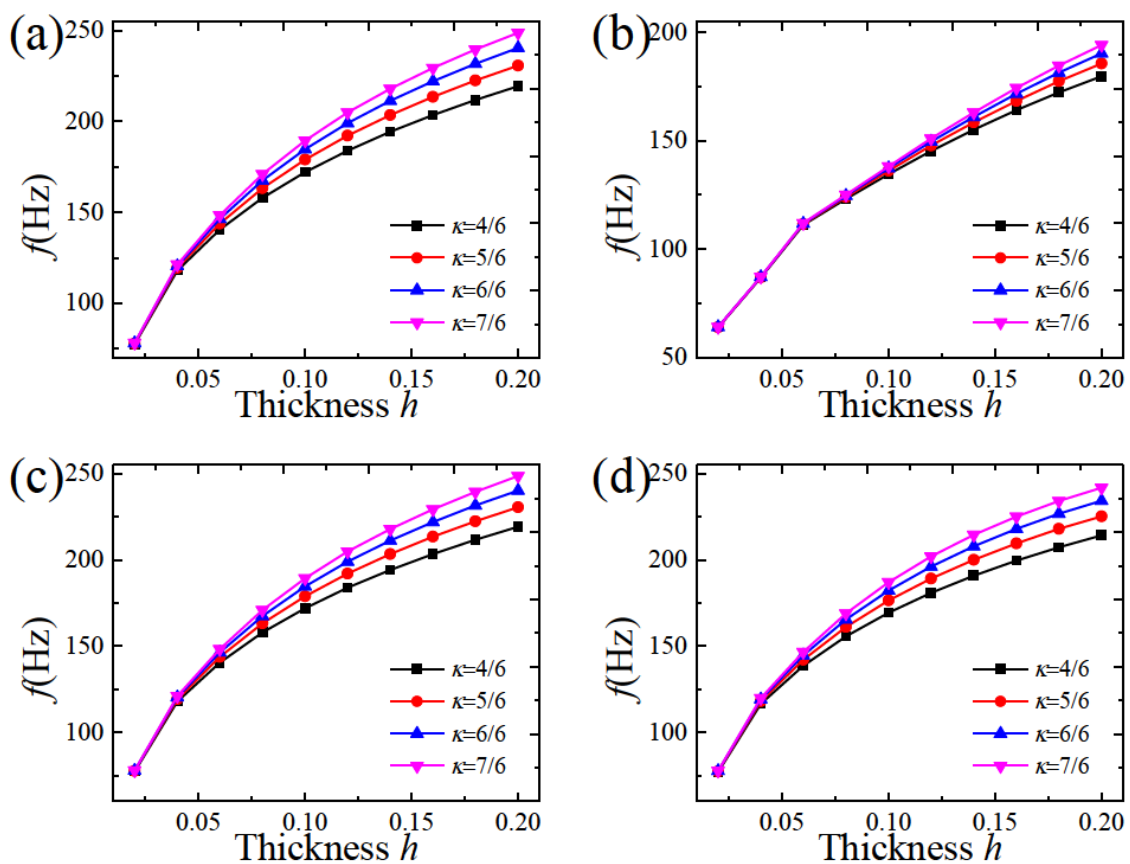
Figure 9: Fundamental frequency parameters versus thickness h for the UD-CNT panel with different shear correction factors and boundary conditions ( V tcnt =0.12): (a) CCCC; (b) SSSS; (c) E 1 E 1 E 1 E 1 ; (d) E 3 E 3 E 3 E 3